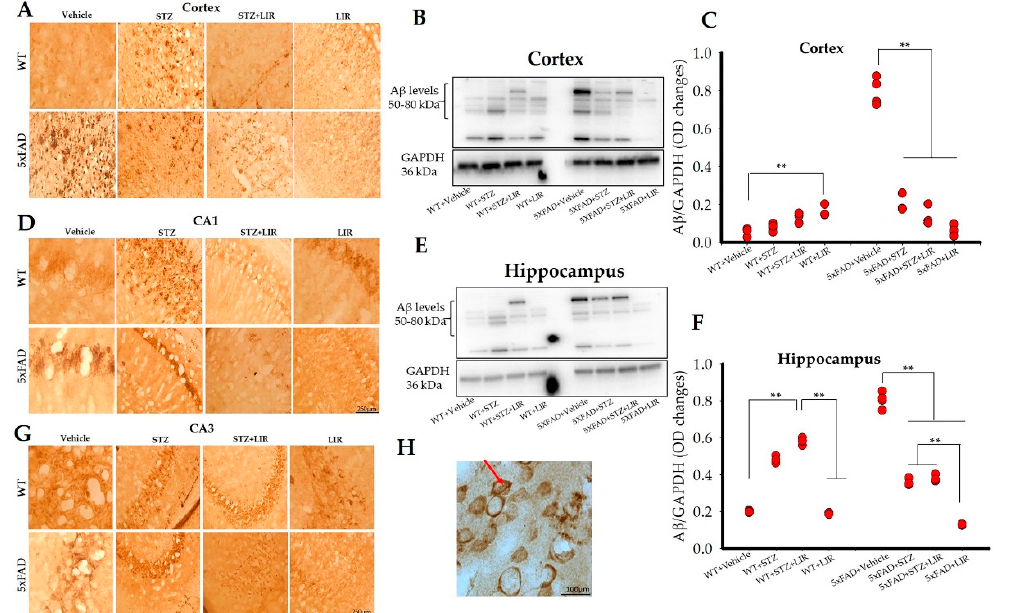
Figure 4. A β protein levels in the cortical and hippocampal regions of the WT and 5xFAD mice. Following LIR treatment, WT and 5xFAD mice ( n = 3 from each group) were sacrificed and perfused transcardially with 4% paraformaldehyde and sectioned at 30 µm on a cryostat and the sections were immunolabelled with 6E10 antibody. ( A , D , G ): Representative 6E10 immunoreactivity for A β levels in the cortical ( A ), CA1 ( D ) and CA3 ( G ) areas of WT and 5xFAD mice. Immunopositive A β (brown) were recognized and stained with 6E10 antibody. ( H ): Representative 100× image showing intraneuronal inclusions (red arrow) in CA1 region of 5xFAD mouse model. Following LIR treatment, WT and 5xFAD mice ( n = 3 from each group) were sacrificed via cervical dislocation, fresh brains were collected, tissue was homogenized after which Western blot analysis was performed. ( B ): Representative Western blot bands showing A β levels in the cortex of both WT and 5xFAD mice. ( C ): Histogram showing densitometric quantification (mean ± SEM) done on A β (from B) normalized with GAPDH. ( E ): Western blot bands showing A β levels in the whole hippocampus of WT and 5xFAD mice. ( F ): Histogram showing densitometric quantification (mean ± SEM) done on A β protein (from E) normalized with GAPDH. Scale bar is 250 µm for all images in A, D and G. Scale bar for 100× image is 100 µm. ** p < 0.01.